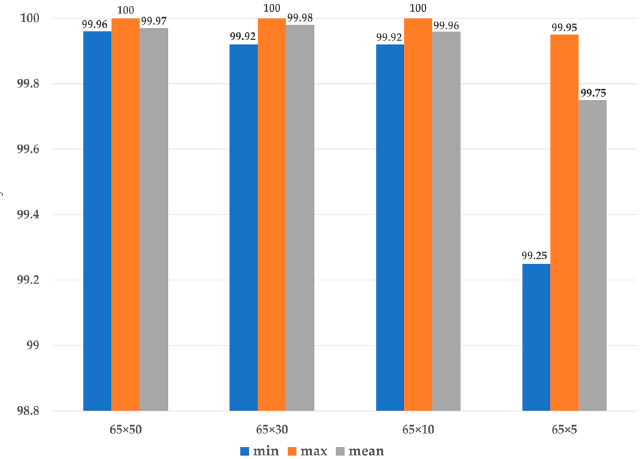
Figure 12. Comparison of the bearing fault diagnosis accuracy of lite CNN models with different input data sizes according to each different length of signal interval.